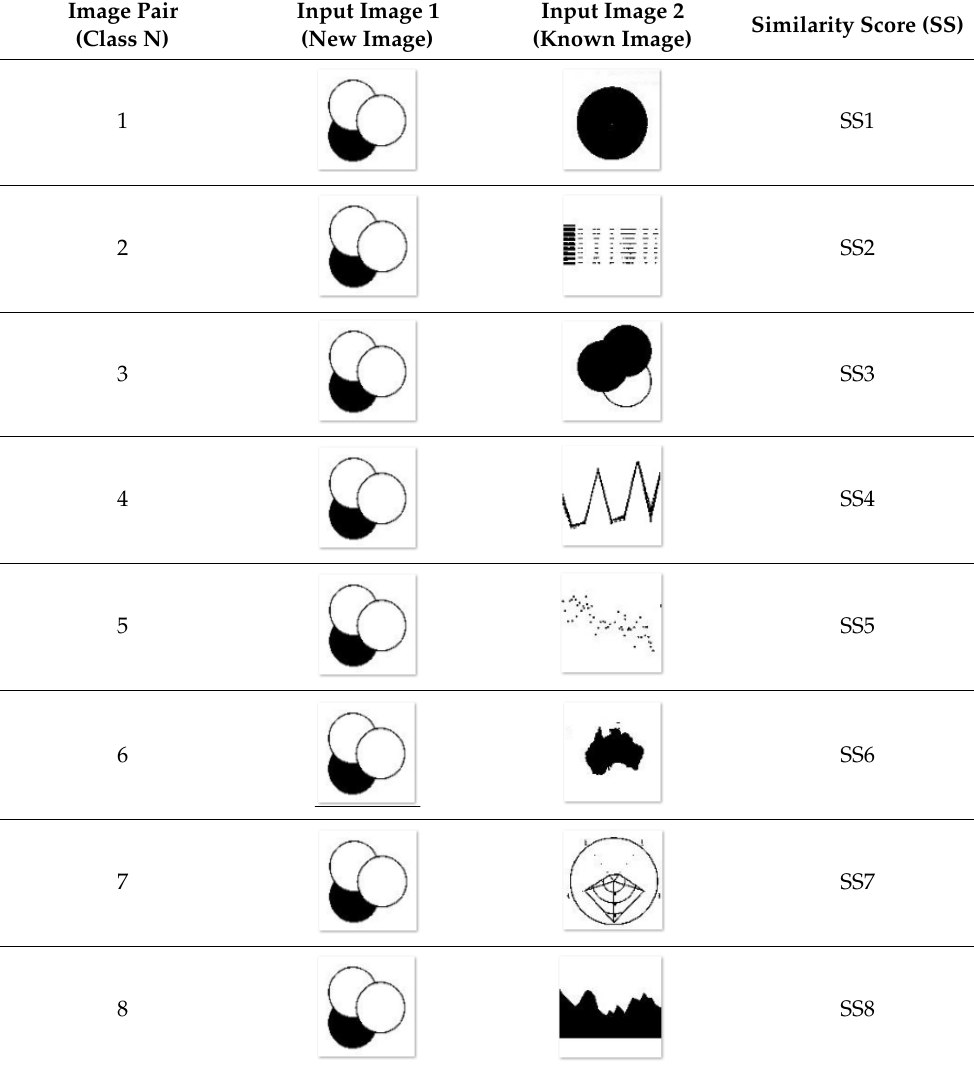
Table 3. Example of a 10-way one-shot learning. The highest expected similarity score should be SS3.